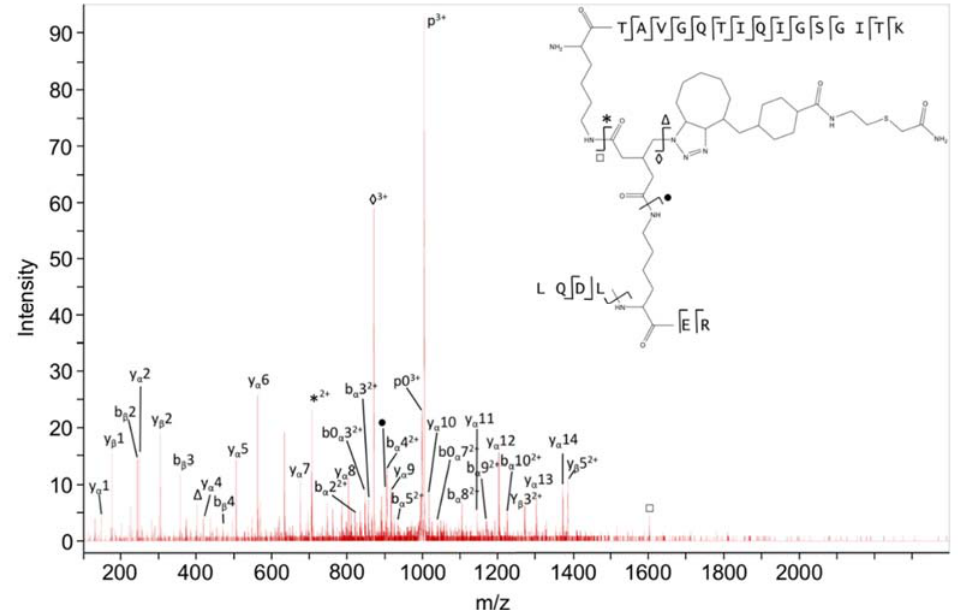
Figure 4. Q-TOF MS/MS spectrum of a cross-linked peptide with K42 from ZapA connected to K51 from FtsZ. Product ions from peptide α and peptide β are annotated according to [37]. The inset shows the structure of the cross-linked peptide, the positions of cleaved bonds, and types of produced ions. P, precursor ion; p0, precursor ion with H 2 O loss. Five products resulting from cleavages in the cross-link remnant are indicated in the structure and corresponding mass peaks by square, star, triangle, diamond and black dot.